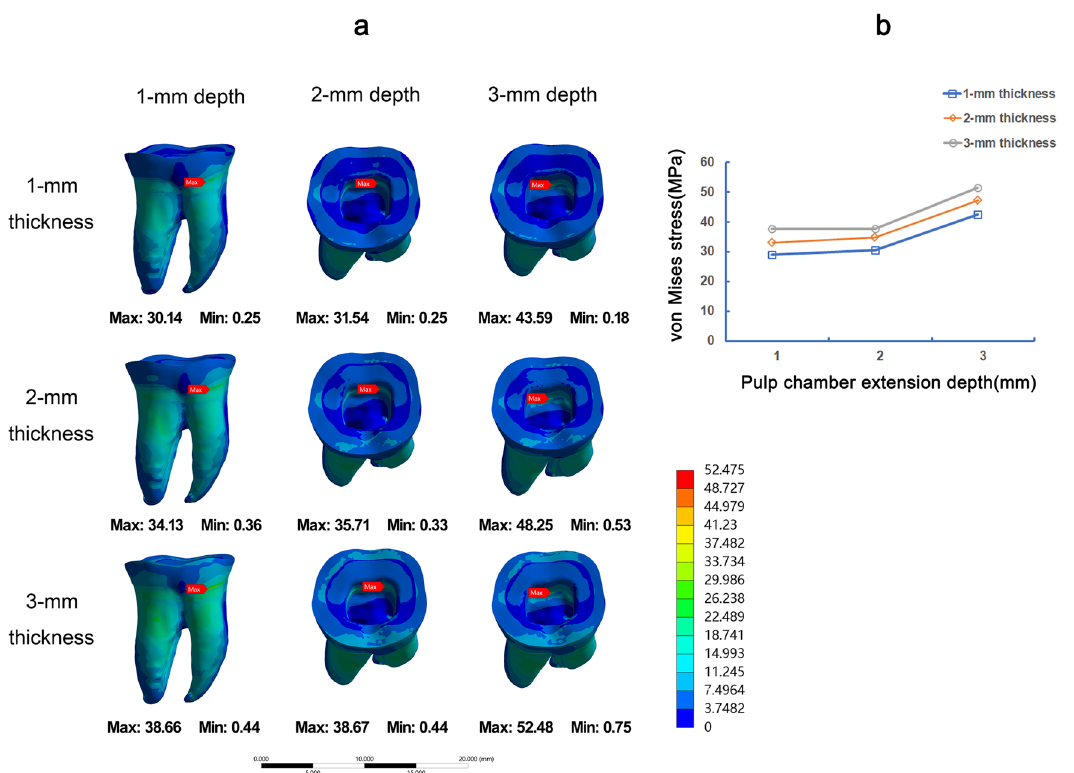
Fig. 7 The von Mises stress (MPa) distribution on teeth tissue in 9 FEA models under horizontal load. Stress distribution plots of teeth tissue by endocrown restorations with 1-mm, 2-mm, or 3-mm pulp chamber extension depth in combination with 1-mm, 2-mm, or 3-mm